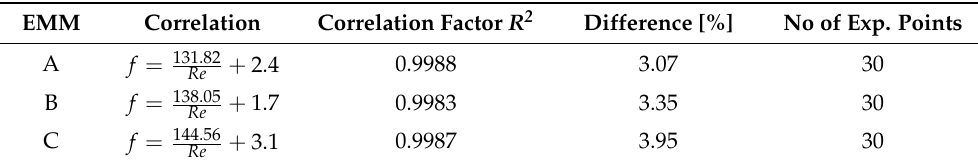
Table 3. Correlations for Fanning friction factors of expanded metal meshes.